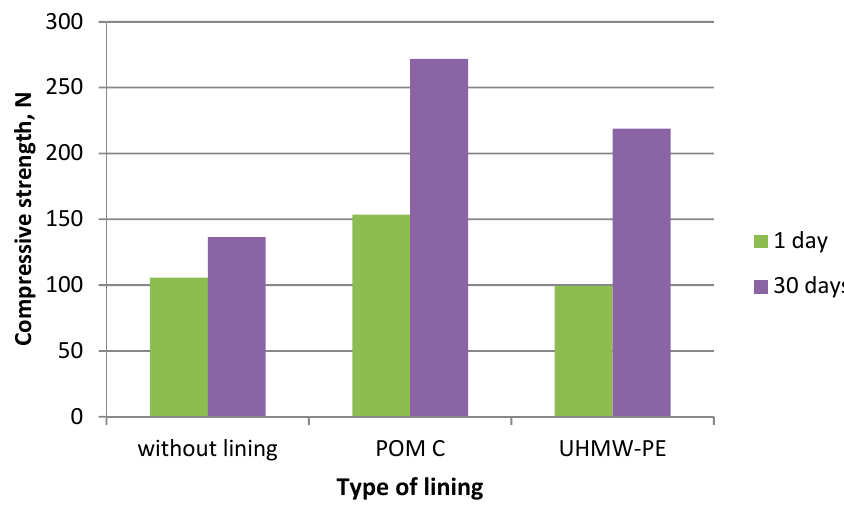
Figure 6. Drop strength of briquettes made of Mixture 1 (calcium hydroxide).